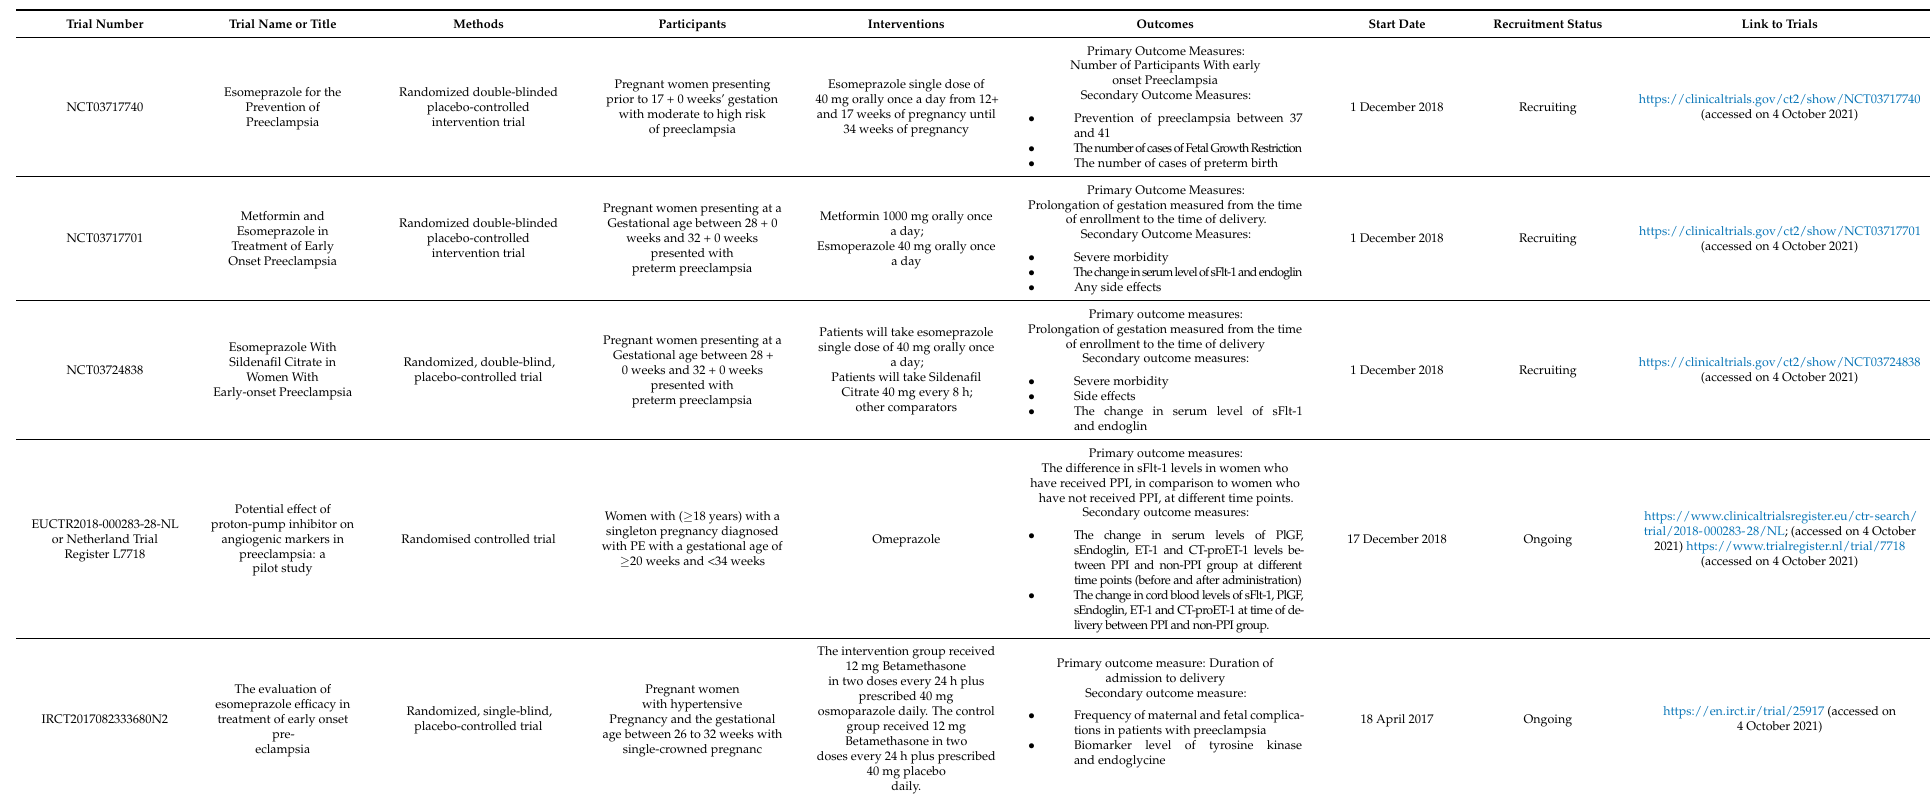
Table 5. List of ongoing clinical